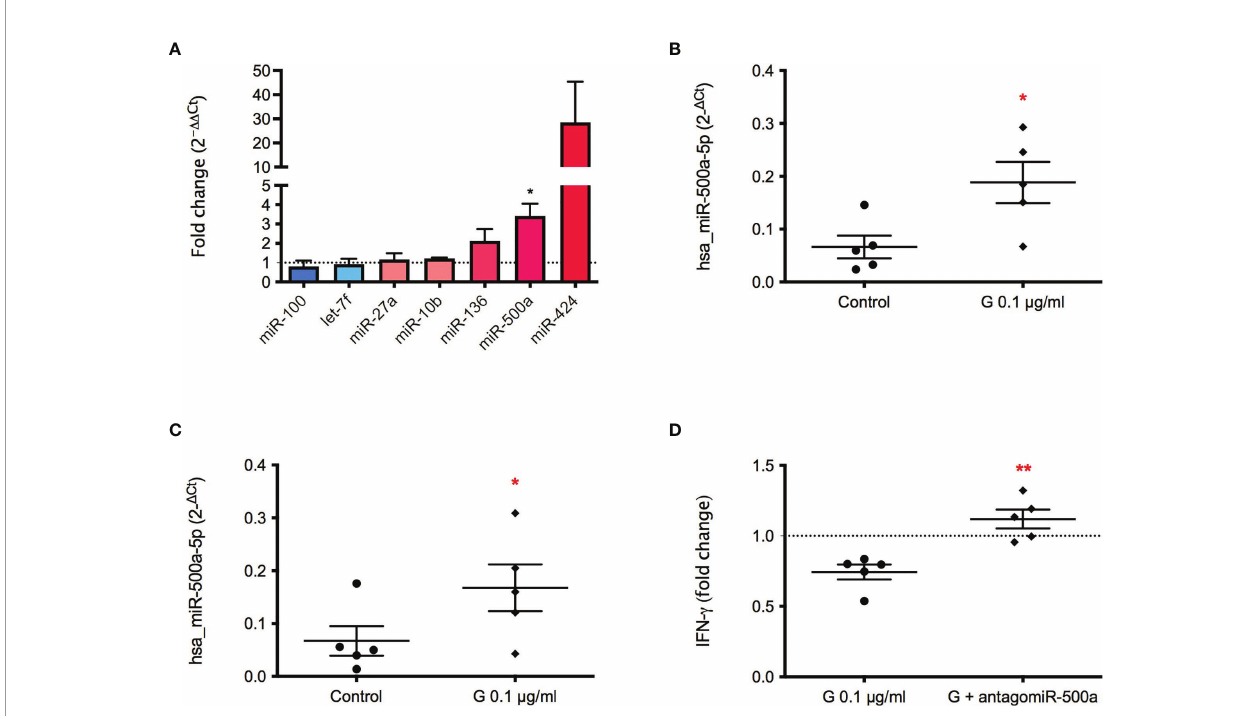
FIGURE 4 | Effect of G on the exosome and intracellular expression of the selected miRNAs. PBMC (10 6 /mL) were treated for 72 h with G (0.1 µg/mL). Exosomes were prepared as described in the Material and Methods section. Total RNA was extracted, retro-transcribed, and target miRNAs were pre-ampli fi ed and detected through Real-Time PCR. (A) Fold-changes (2 − DD Ct ) of the selected miRNAs in exosomes (hsa_miR-10b, hsa_miR-27a, hsa_miR-100, hsa_miR-136, hsa-miR-424, hsa_miR-500a, hsa_let-7f) are reported. (B) Fold-change (2 − D Ct ) of hsa_miR-500a contained in exosomes. (C) Fold-change (2 − D Ct ) of intracellular hsa_miR-500a. hsa-RNU6-2 as negative control. (D) Role of miR-500a in IFN- g production. PBMC (40 ’ 000 cells per well) were silenced with the inhibitor of hsa_miR-500a-5p for 24 h, after medium replacement cells were treated with G (0.1 µg/mL) for 1 h and then with PMA and ionomycin for 72 h. IFN- g was measured by ELISA in cell-free supernatants. In (B, C) dots represent the individual values of control cells and rhombuses of G-treated cells for each donor. In (D) each dot represents the fold change of IFN- g release induced by G of each individual, whereas rhombuses represent the fold change of IFN- g release obtained from antagomir pre-treatment. Each value represents the mean ± SEM, n = 5 donors. Statistical analysis was performed with Paired t test, with * p < 0.05 and ** p < 0.01 vs control cells (or G- treated cells for (D)